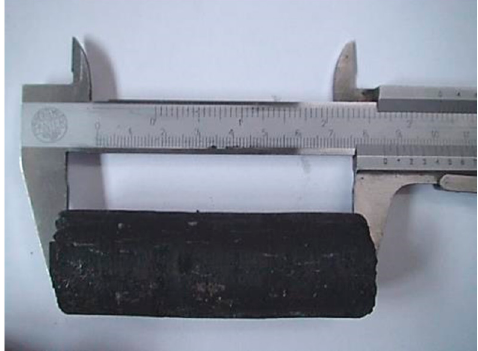
Figure 5. The length of the tested coal sample.